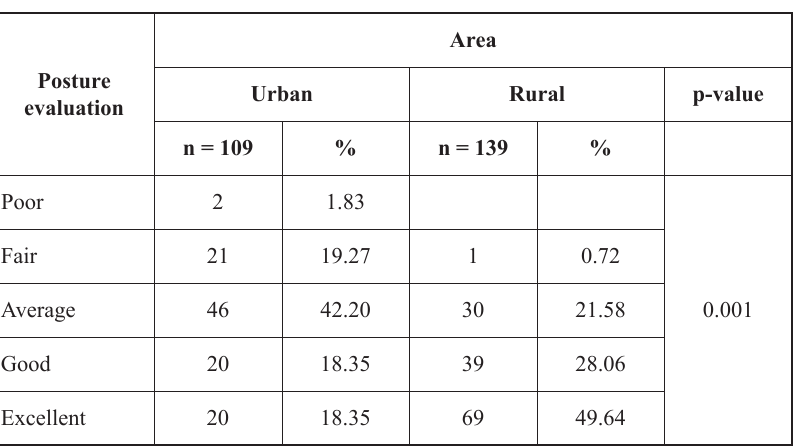
Table 2. Distribution of subjects’ posture evaluation according to